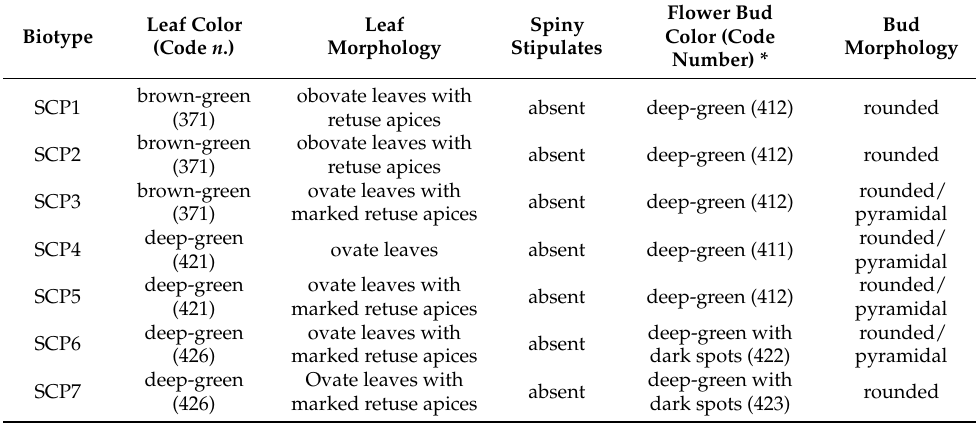
Table 1. Main morphological characteristics of Capparis spinosa L. subsp. rupestris biotypes.